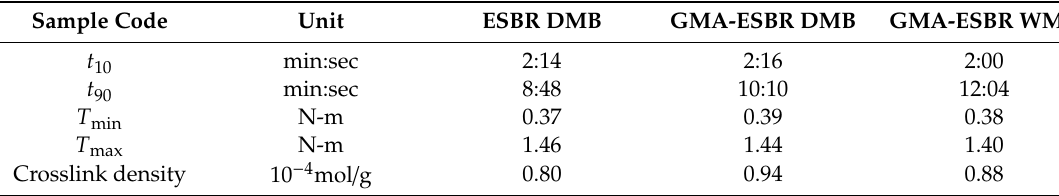
Figure 4 . Cure characteristics of ESBR and GMA-ESBR compounds. Figure 4. Cure characteristics of ESBR and GMA-ESBR compounds. Table 7. Cure characteristics and crosslink densities of ESBR and GMA-ESBR